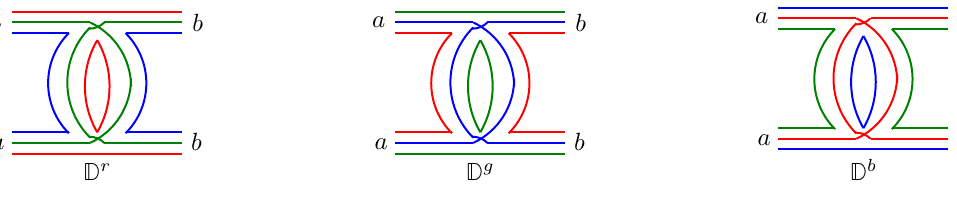
Figure 12. Dipoles D c